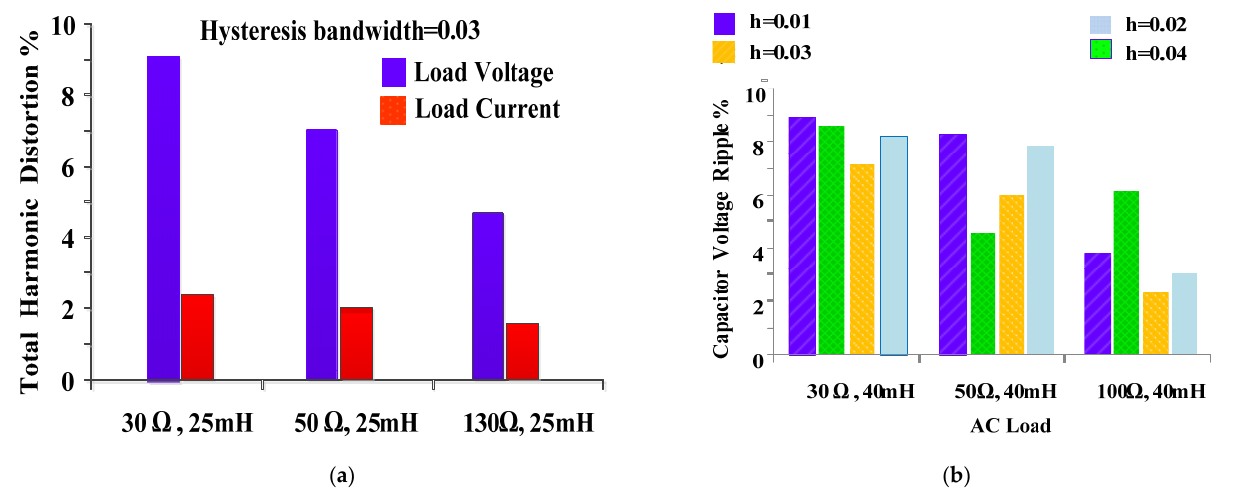
Figure 10. ( a ) Percentage voltage and current THD at different load impedance and at different bandwidth. ( b ) Percentage ripple in the capacitor voltage at different load impedance and at different bandwidth ( h ).